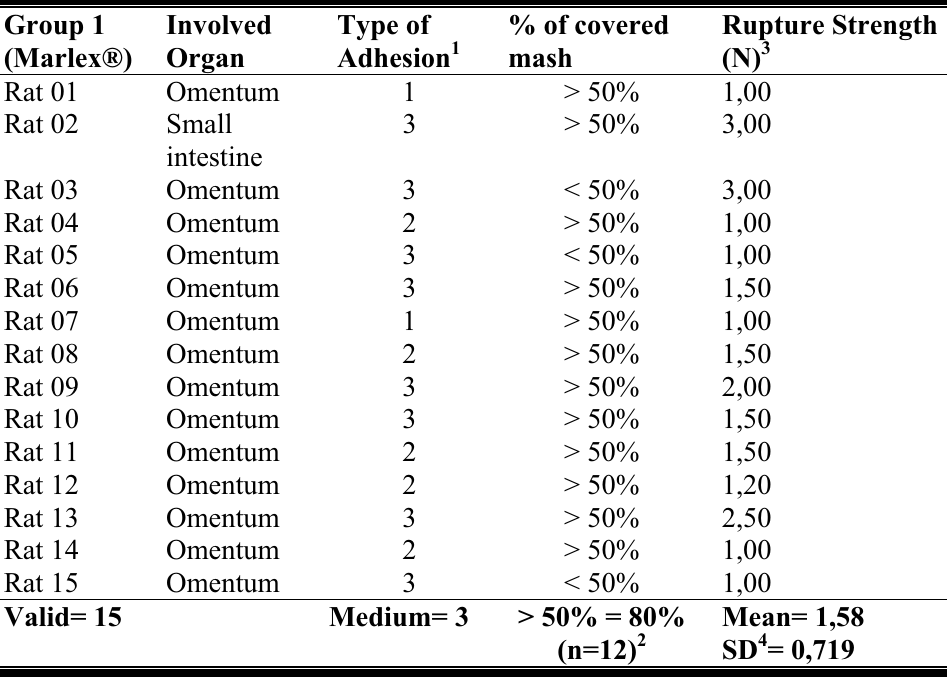
TABLE 2 - Results obtained for Group 1